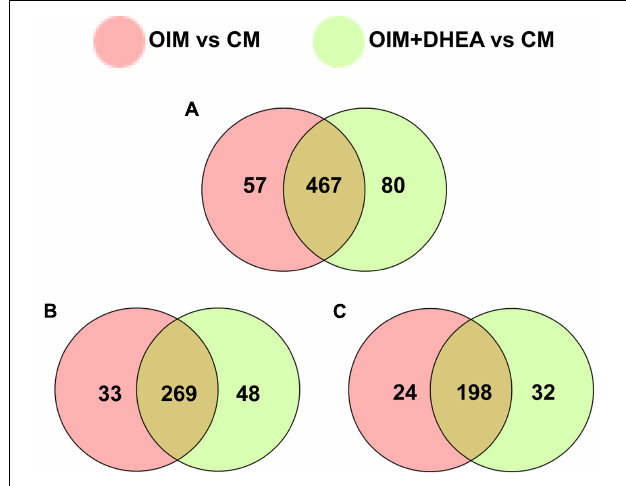
FIGURE 3 | Analysis of differentially expressed proteins (DEPs) between two different comparative groups. (A) Venn diagram of DEPs comparing between OIM vs. CM and OIM+DHEA vs. CM. (B) Venn diagram of up-regulated proteins comparing between OIM vs. CM and OIM+DHEA vs. CM. (C) Venn diagram of down-regulated proteins comparing between OIM vs. CM and OIM+DHEA vs. CM.